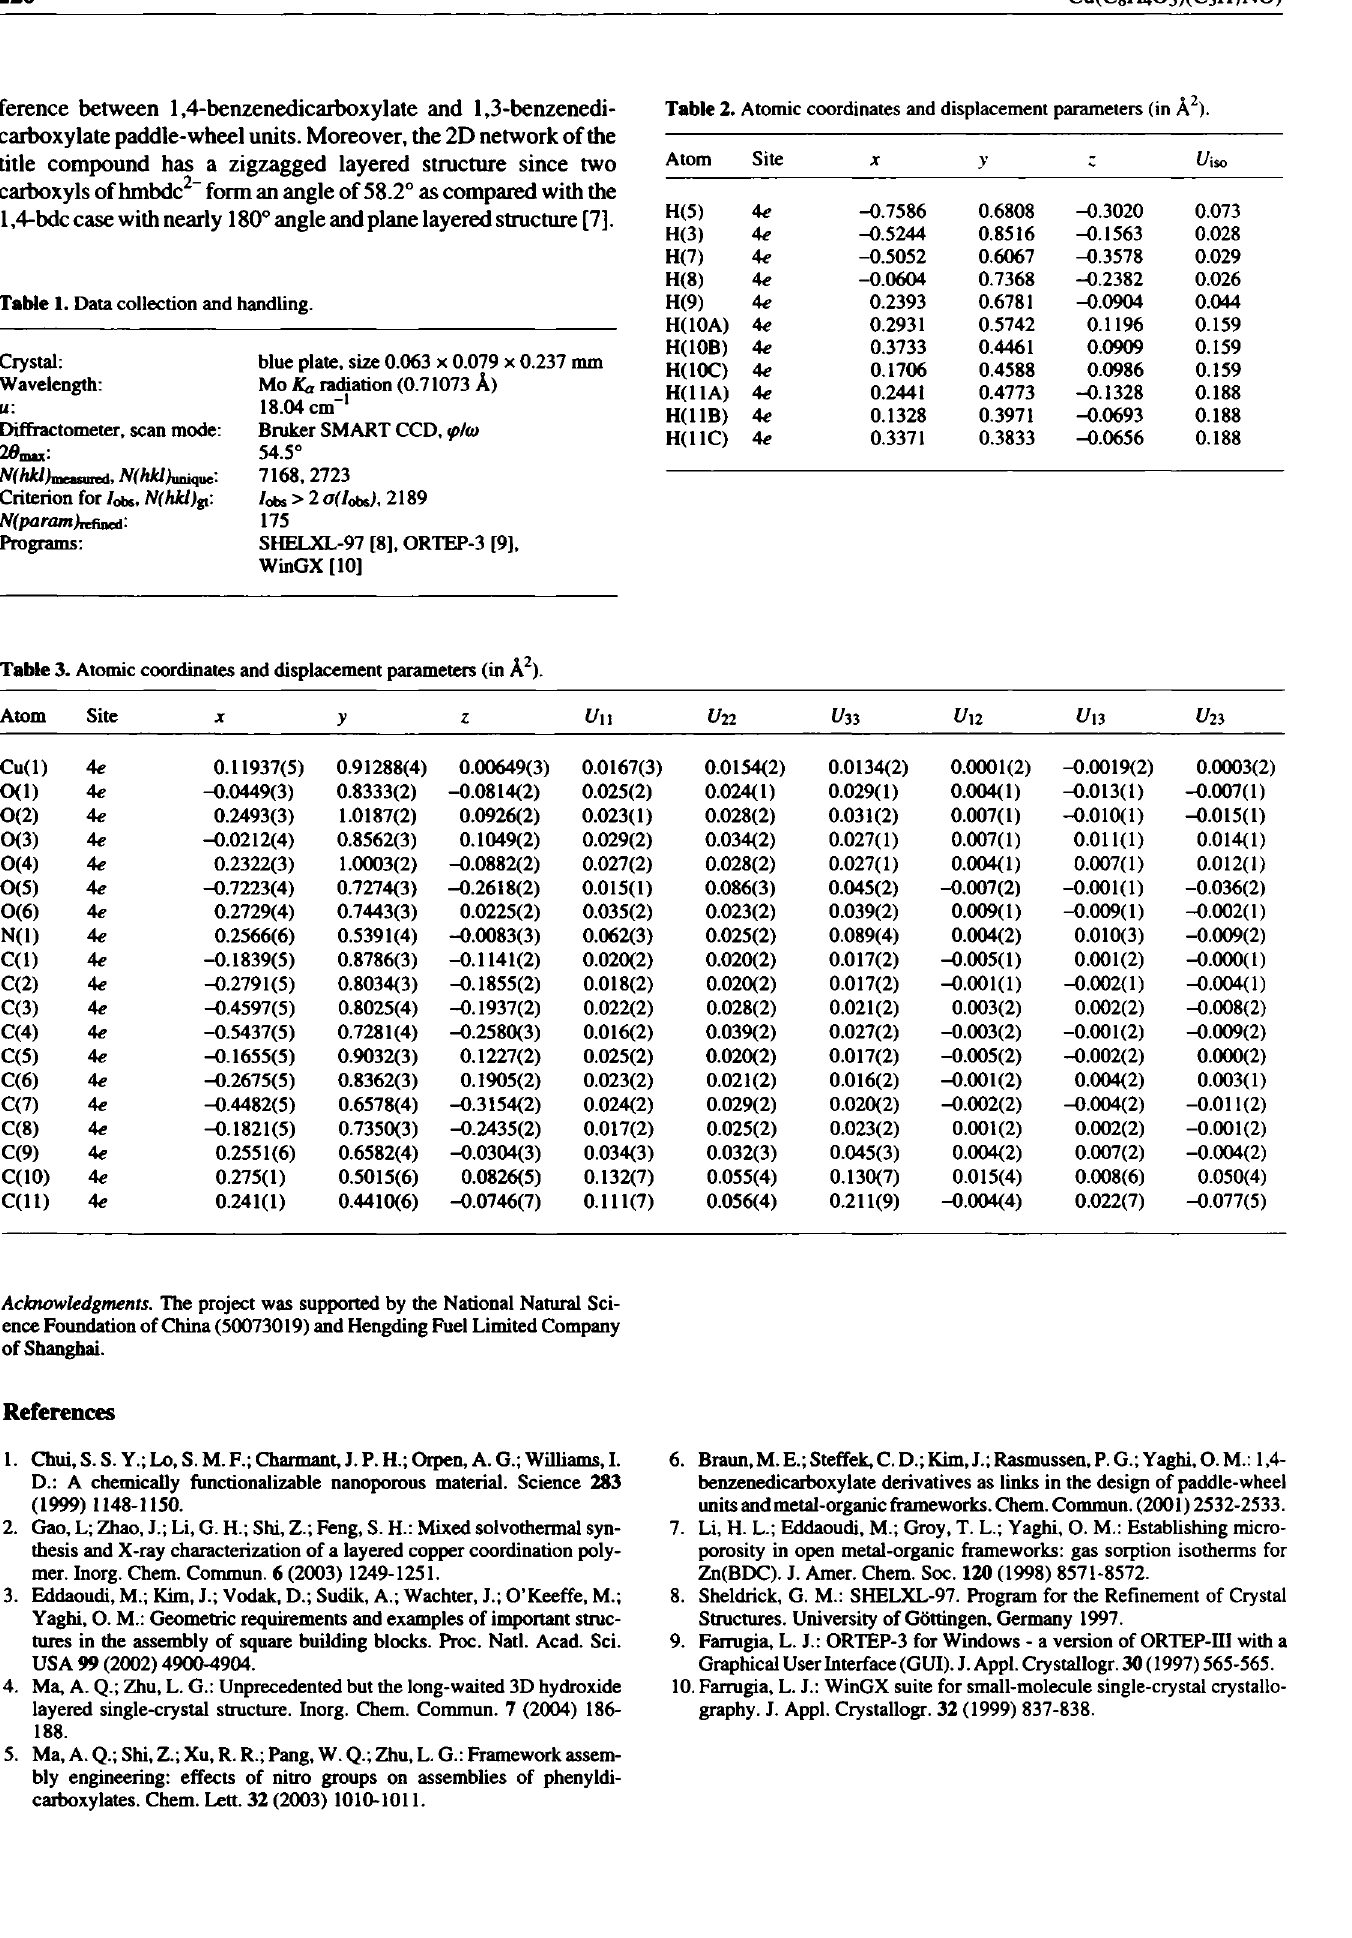
Table 2. Atomic coordinates and displacement parameters (in À 2 ).